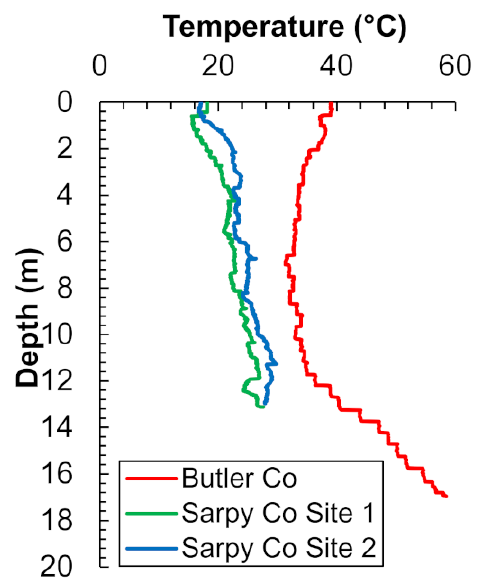
Figure 5. Temperature changes with